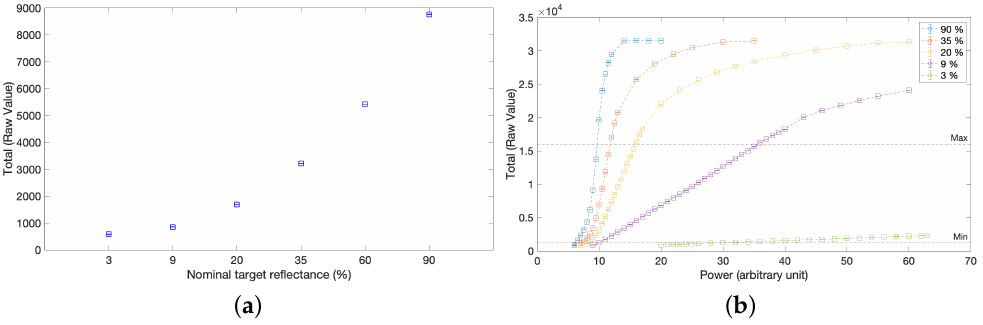
Figure 5. Linearity test on diffusive reflectance standards. ( a ) Variation of the intensity signal Total with respect to the change in target reflectance for a fixed power configuration (course power (arbitrary unit) set at 9, 16 fine power). ( b ) Variation of the intensity signal Total as the laser power varies and as the target reflectance